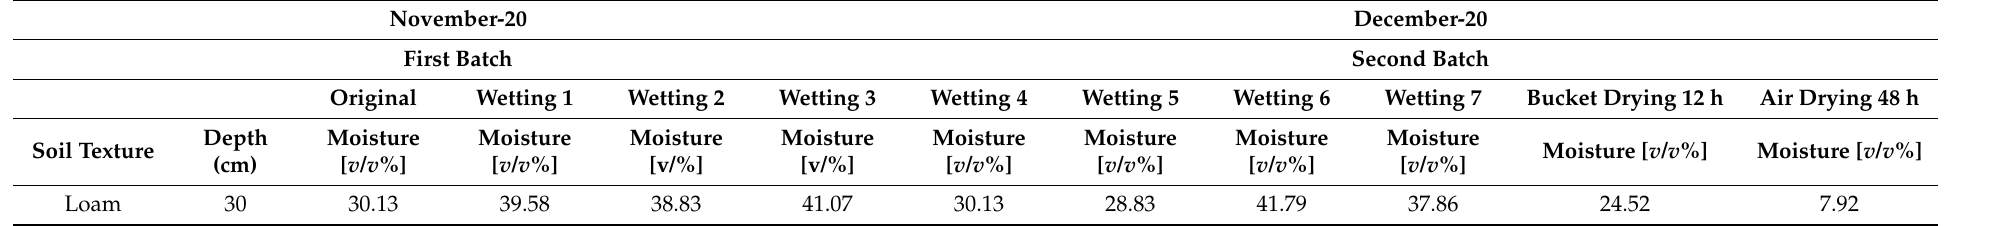
Table 8. Loam Laboratory calibration—Volumetric water content from Gravimetric